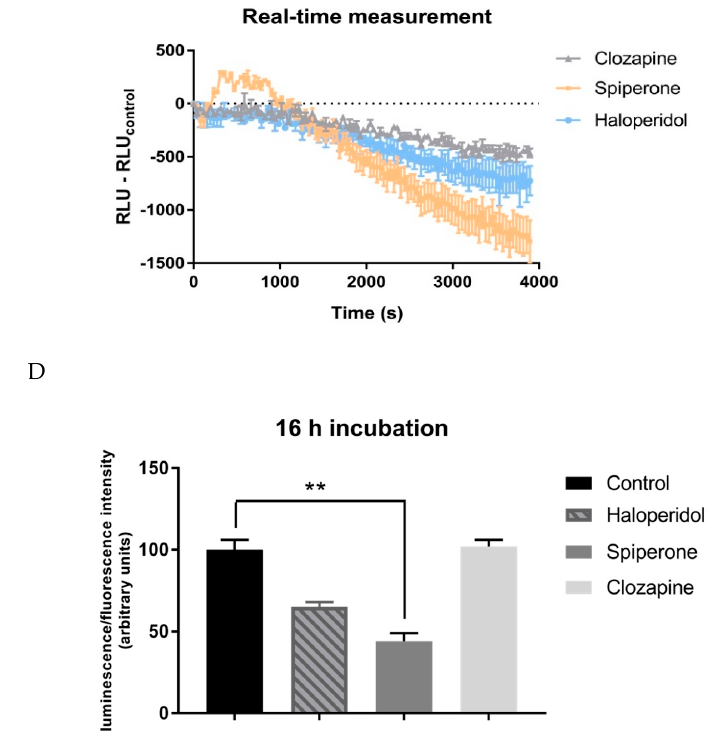
Figure 2. Detection of the D 2L R homodimer using the complementation-based NanoLuciferase Binary Technology (NanoBiT). The SmBiT and LgBiT split parts of the NanoLuciferase are fused to the C-terminus of the G protein-coupled receptors (GPCRs). Overexpression of these constructs was conducted by transient transfection in HEK293T cells. The luminescent signal was normalized to the fluorescent signal of the co-transfected Venus protein in all conditions: ( A ) A non-interacting GPCR partner for D 2L R (from a panel of multiple GPCRs) is the cannabinoid receptor 2 (CB2), which showed a 4-fold lower signal compared to the D 2L R–D 2L R interaction. ( B ) Real-time measurement of adherent transfected HEK293T cells incubated with 10 µM of D 2 R antagonists for 1 h. Normalized relative luminescence unit (RLU) is plotted against time (s) ( n = 2, ±SEM). ( C , D ) Signals obtained following incubation of D 2L R–LgBiT and D 2L R–SmBiT transfected HEK293T cells with the D 2 R antagonists haloperidol, spiperone, and clozapine (10 µM) for 4 h ( C ) or 16 h ( D ). Control = solvent-treatment (DMSO ≤ 0.1%). Spiperone reduced the level of D 2L R dimerization by ≥ 40% in all conditions ( n = 5, ±SEM) (non-parametric Kruskal–Wallis one-way Anova, followed by post-hoc analysis (Dunn’s multiple comparison test), * p < 0.05, ** p < 0.01, **** p < 0.0001).